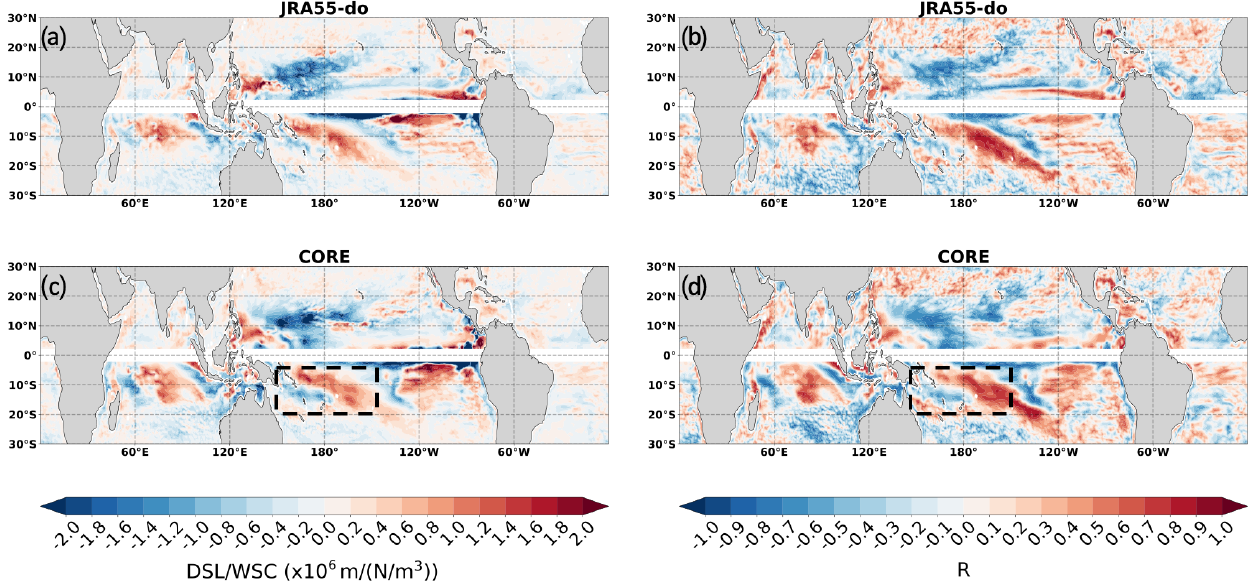
Figure 27. The regression coefficients between wind stress curl and DSL anomaly during the El Niño composite (1958–2007) in (a) JRA55- do and (c) CORE. The R value from the regression in (b) JRA55-do and (d) CORE. The dashed black boxes show the region of asymmetric sea level changes in the southwestern tropical